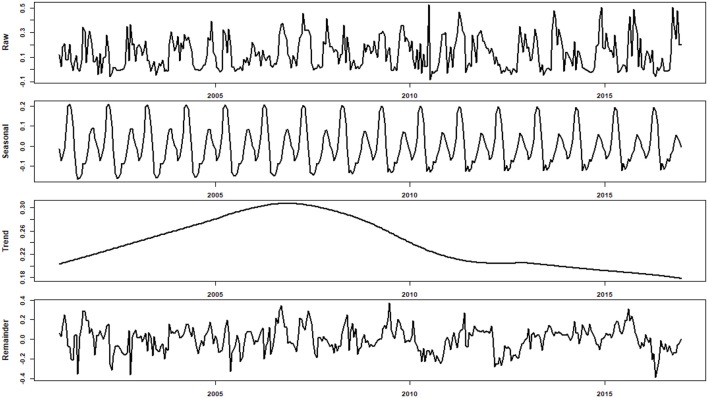
An example of the raw, decomposed seasonal, trend, and remainder of EVI time series at controlled site. The seasonality was stable for the study period. The trend showed a distinct pattern comparing to connected sites: the EVI increased continuously till 2006, since which a decreasing trend was evident although the decreasing rate was much smaller since 2003.